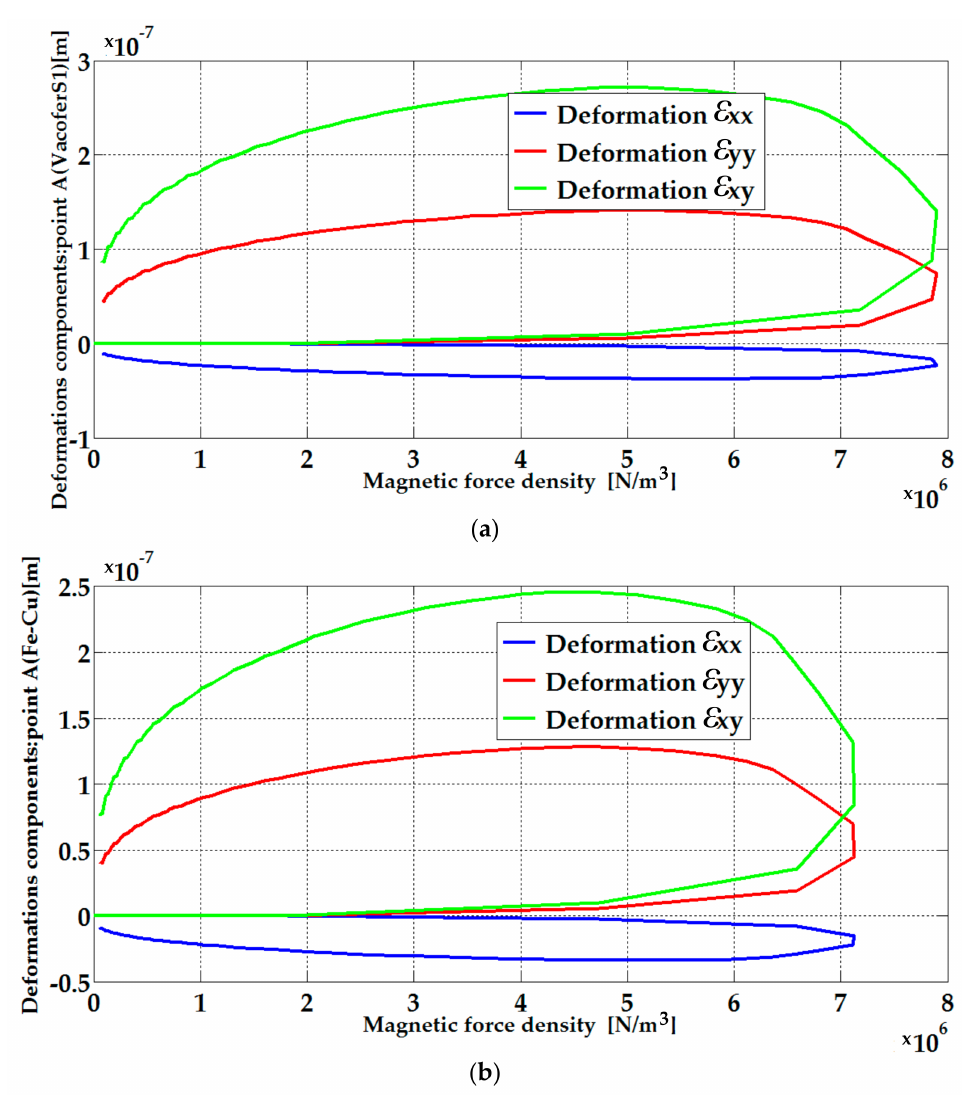
Figure 12. Time evolution of deformation components in the non-linear magnetic and conductive materials: ( a ) VACOFER S1, ( b ) Fe–Cu